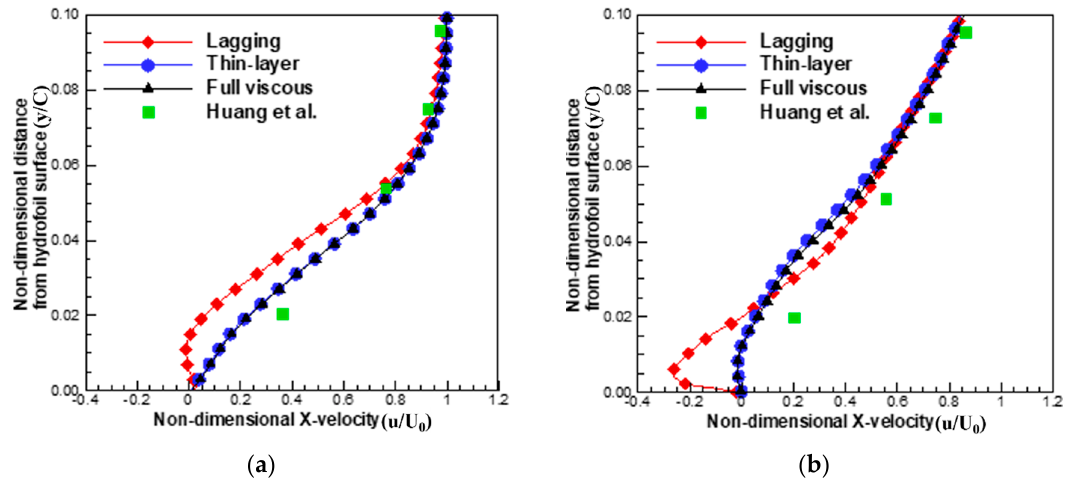
Figure 16. Comparison of zoomed time-averaged x-directional velocity distribution with experimental results by Huang et al. [40]: ( a ) x/C = 0.4; and ( b ) x/C = 0.6.